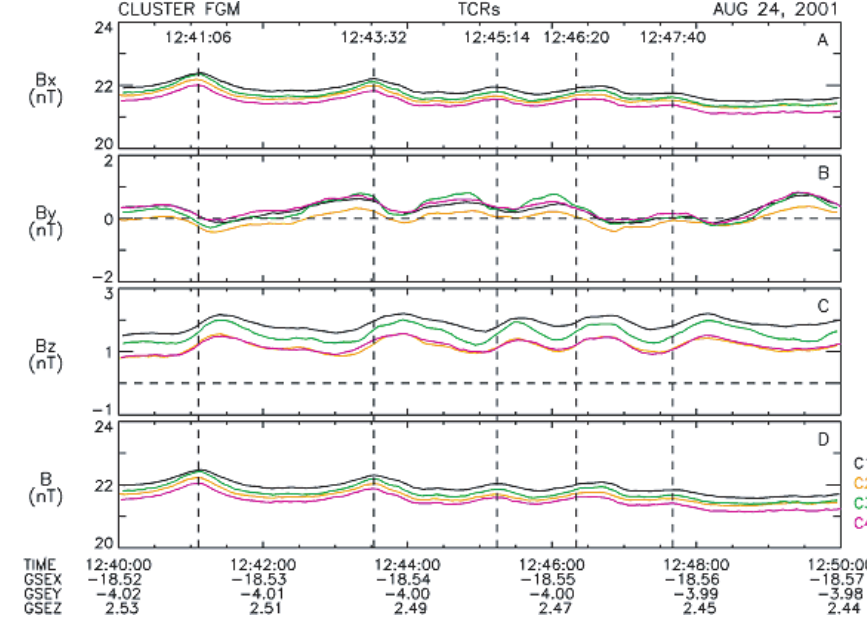
Fig. 8. Example of a multiple SN TCR event observed on 24 October